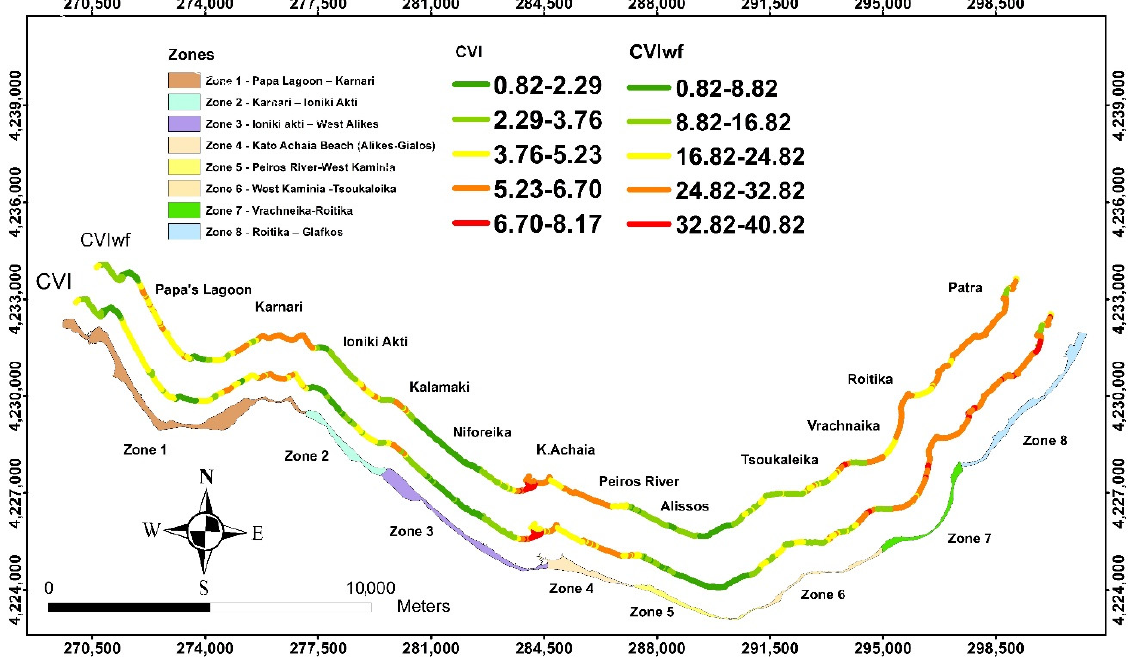
Figure 8. Spatial distribution of CVI and CVI WF alongside the shoreline of the Gulf of Patras. The geotechnical weighted factor decreased the vulnerability class on some segments of the coastline, which were mapped as cobble and gravel beaches (D 50 > 2.50 mm) from high to moderate. On the contrary, an increase of the vulnerability class was observed on some segments of the coastline that were mapped as sandy beaches (D 50 < 2.50 mm) from moderate to high. The addition of a weighted geotechnical factor in the CVI WF equation changed the coastal vulnerability to a lower class in gravel and cobble beaches and a higher class in sandy beaches, which is more accurate for this particular area. 4.8. Analysis on the Computed EPR Values and the Respective CVI WF Results In Zone 1, the EPR shows that most of the coastline is under accretion, despite the fact of the existence of a geotechnical unit (fine sand) and a gentle coastal slope of very high vulnerability (CVI rank 5). However, in the eastern part of Zone 1 (Karnari Beach), erosion is observed with a rate ranging from − 1.00 to − 1.50 m/y, and this agrees mostly with the CVI WF results (Figure 9). In Zone 2, the EPR reveals that most of the coastline is under erosion, with a rate ranging from − 1.00 to − 1.50 m/y. The CVI and CVI WF results show this area as lowly vulnerable in its western part and moderate-to-highly vulnerable in its eastern part. Those differences between the CVI WF and EPR is due to the steeper coastal slope and the rocky coast existing in the western part of Zone 2 (Figure 9). A lower erosion rate with an EPR − 0.40 to − 0.80 m/y exists in Zone 3, especially in the western and eastern parts, which decrease at − 0.30 to 0.00 m/y in the central part. Both the CVI and CVI WF results reveal high and very high vulnerabilities in the western and eastern parts of the zone, respectively, being in agreement with their respective EPR, which becomes a low vulnerability in the central part of the zone due to the existence of a higher coastal slope with soft rocks/hard soils (CVI rank 1) (Figure 9). In Zone 4, erosion dominates, apart from a very small accretion area in its central part. EPR is very high in the eastern part ( − 1.00 to − 1.50 and > − 1.50 m/y), where a dam was constructed upstream; thus, it blocks the sediment movement towards the coastline, and this agrees mostly with the CVI WF re- sults (Figure 9).